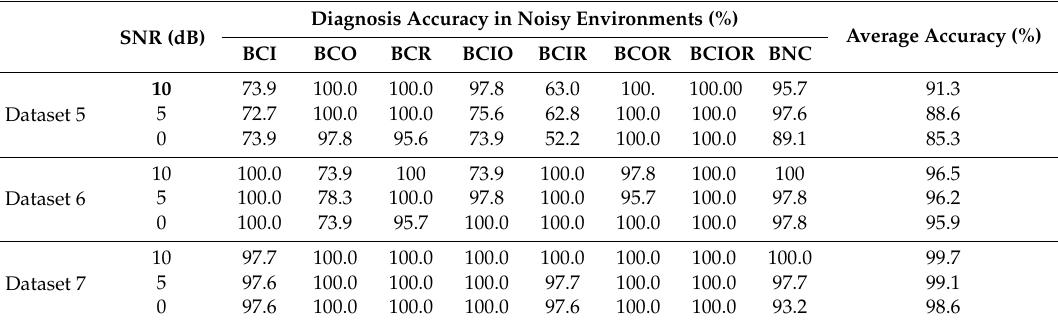
Table 6. Diagnosis accuracy in noisy